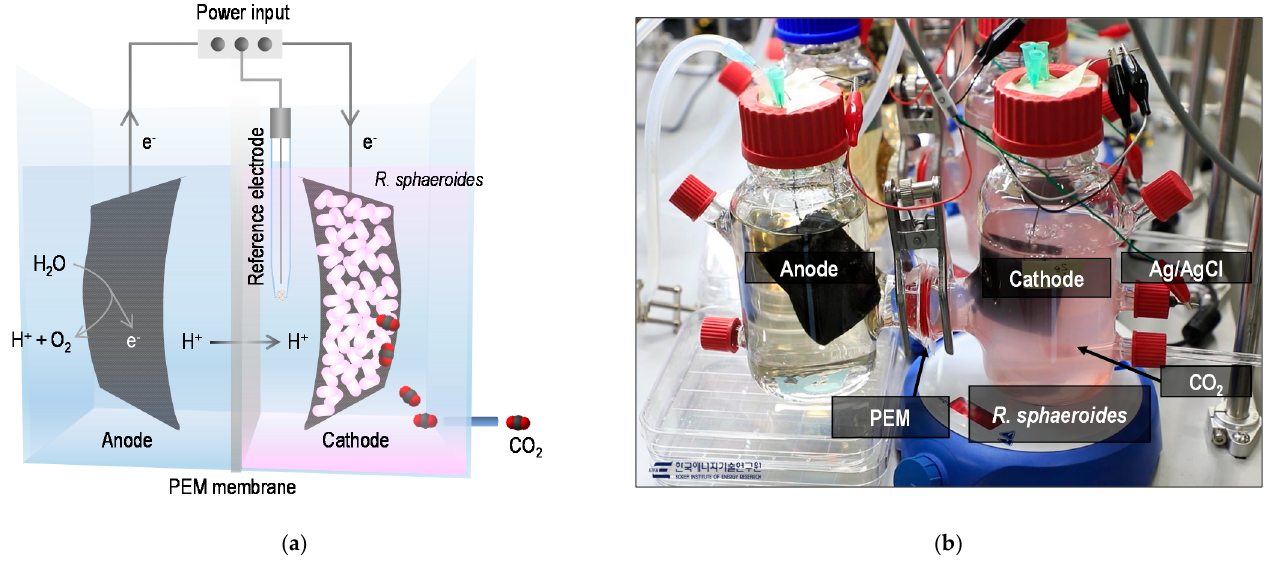
Figure 2. ( a ) Schematic representation and ( b ) Photograph of the microbial electrosynthesis reactor used for conversion of CO 2 . CO 2 conversion was performed in growth medium (pH 7.0) without a carbon source other than supplementation with 5% CO 2 at an applied potential of − 0.6 V (vs. Ag/AgCl).